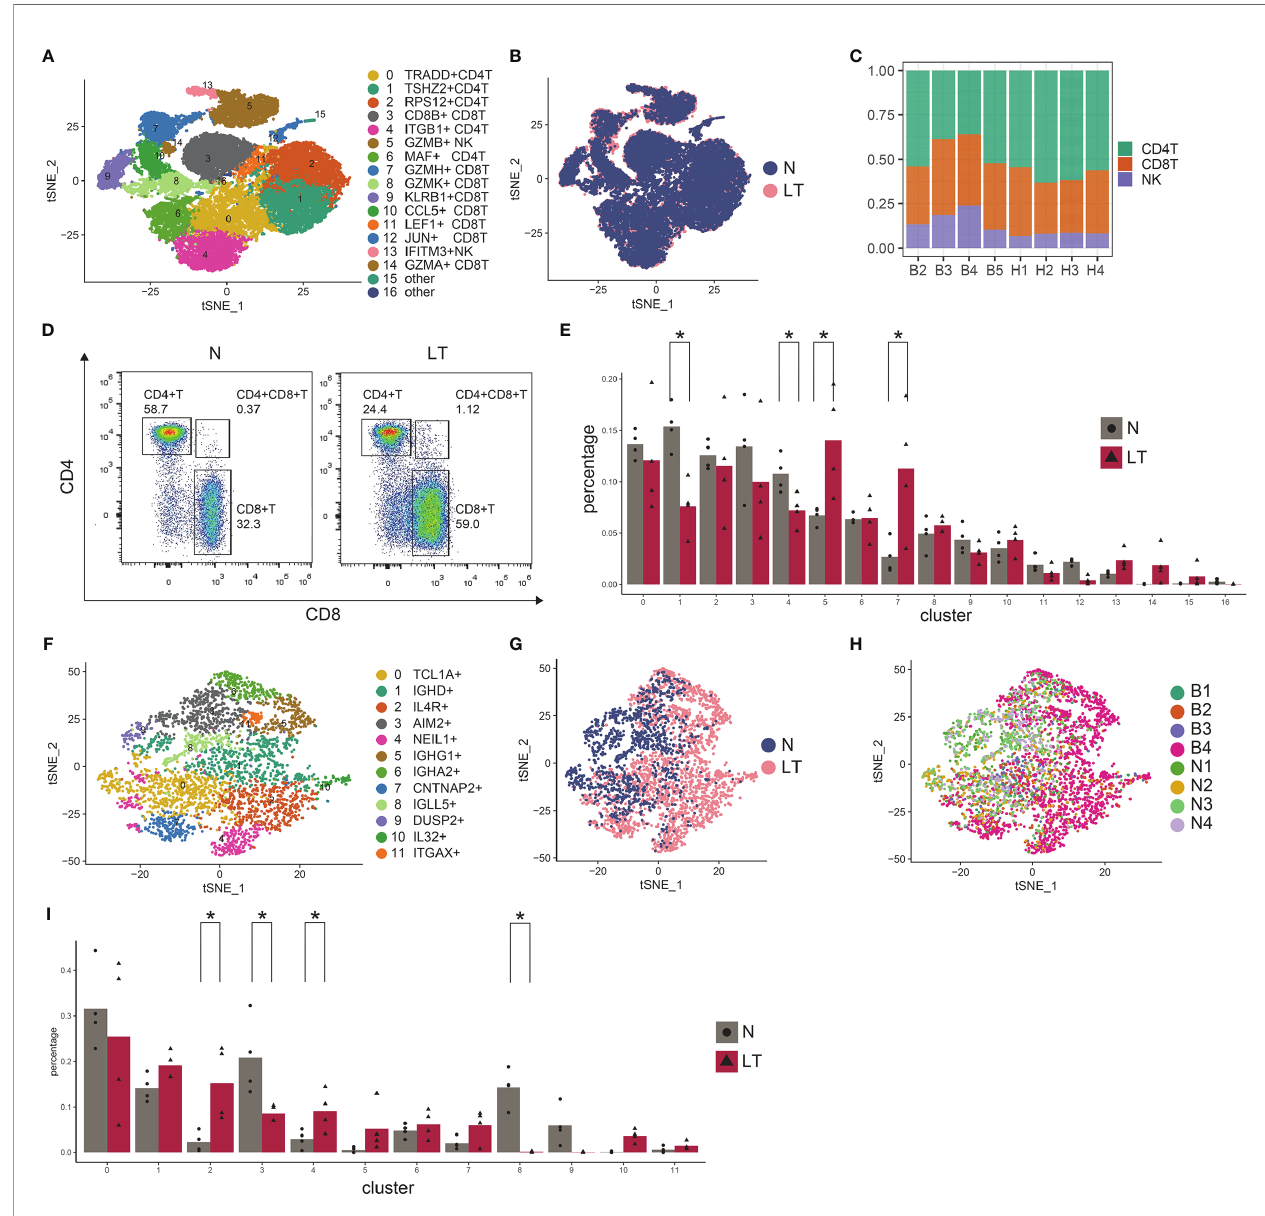
FIGURE 3 | Identifying T and NK cell subpopulations in PBMC. (A) Clustering of 30,465 T and NK cells and cell annotation. (B) tSNE plot colors by spatial distribution of cells in normal (n=4) and liver transplantation (n=4) human tissues. (C) tSNE plot colors by spatial distribution of cells in 8 samples. (D) Flow cytometry analysis of CD4+ T cells and CD8+ T cells fraction in normal and liver transplantation tissues. (E) Fractions of T, NK cell subpopulations in normal (n=4) and liver transplantation (n=4) samples (* means p < 0.05). (F) Clustering of 3786 B cells. (G) tSNE plot colors by spatial distribution of cells in normal (n=4) and liver transplantation (n=4) human tissues. (H) tSNE plot colors by spatial distribution of cells in 8 samples. (I) Fractions of B cell subpopulations in normal (n=4) and liver transplantation (n=4) samples (* means p <